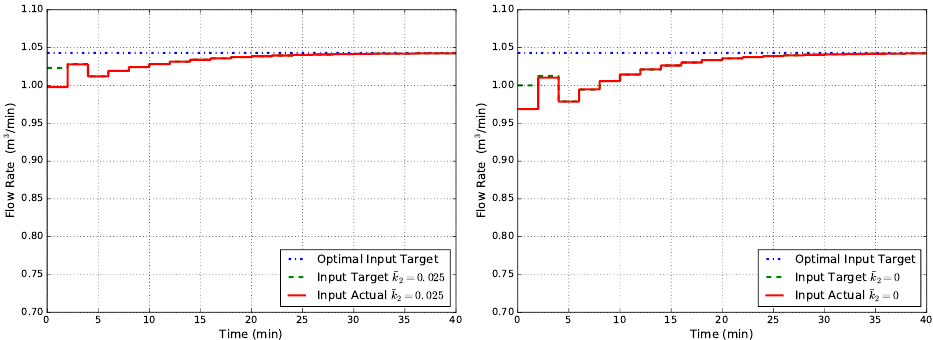
Figure 7. Closed-loop flow rate Q obtained with MPC1-MT (state disturbance model, modified target problem, tracking cost in the finite horizon optimal control problem (FHOCP)) for two cases of uncertainty in k 2 : ¯ k 2 = 0.025 ( left ) and ¯ k 2 = 0 ( right